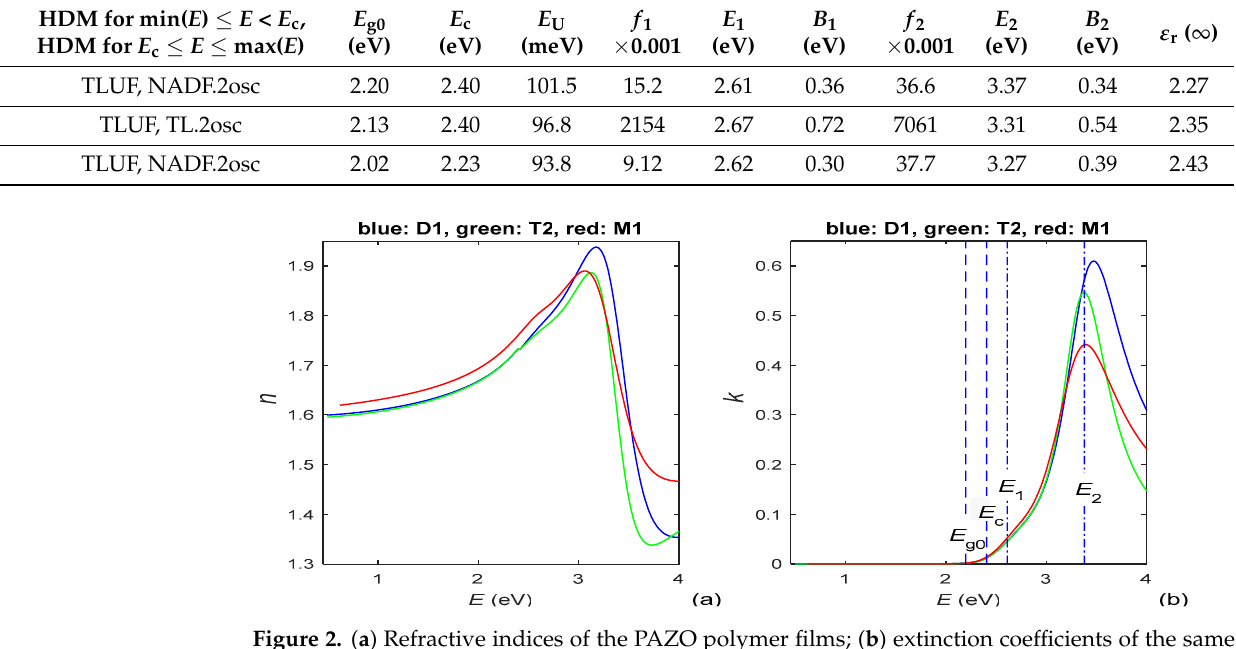
Figure 2 . ( a ) Refractive indices of the PAZO polymer films; ( b ) extinction coefficients of the same films. Some important energies for the film D1, among the data in Table 1, are illustrated by vertical blue lines.